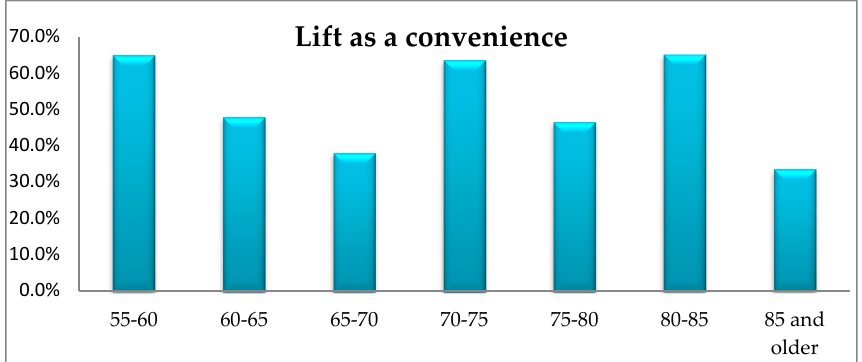
Figure 9. The respondents’ age vs. their opinion about the need of a lift in their immediate environment.